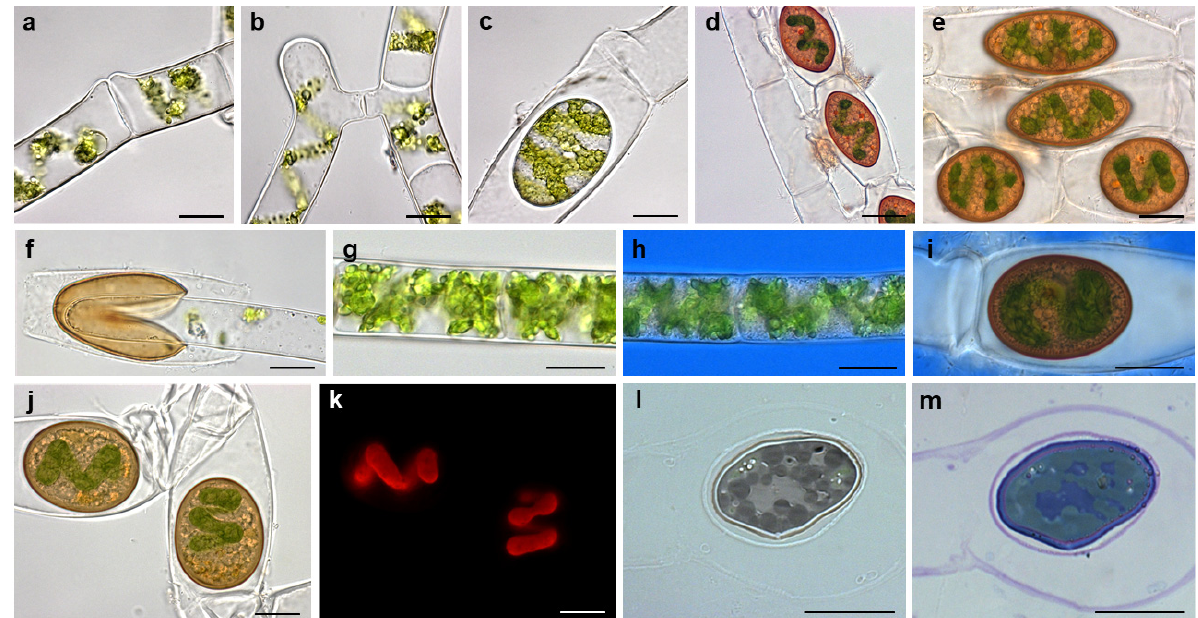
Figure 2. Conjugation and zygospores of Spirogyra mirabilis : ( a ) lateral conjugation, ( b ) scalariform conjugation, ( c ) zygospore formed by lateral conjugation, ( d ) zygospores formed by scalariform conjugation, ( e ) polymorphic zygospores, ( f ) germinating zygospore, ( g ) vegetative filament, ( h ) vegetative filament stained with Indian ink, ( i ) zygospore stained with Indian ink, ( j ) zygospores with chloroplast with ( k ) corresponding chlorophyll autofluorescence image, ( l ) semi-thin section with ( m ) corresponding toluidine staining. Scale bars 20 µm .